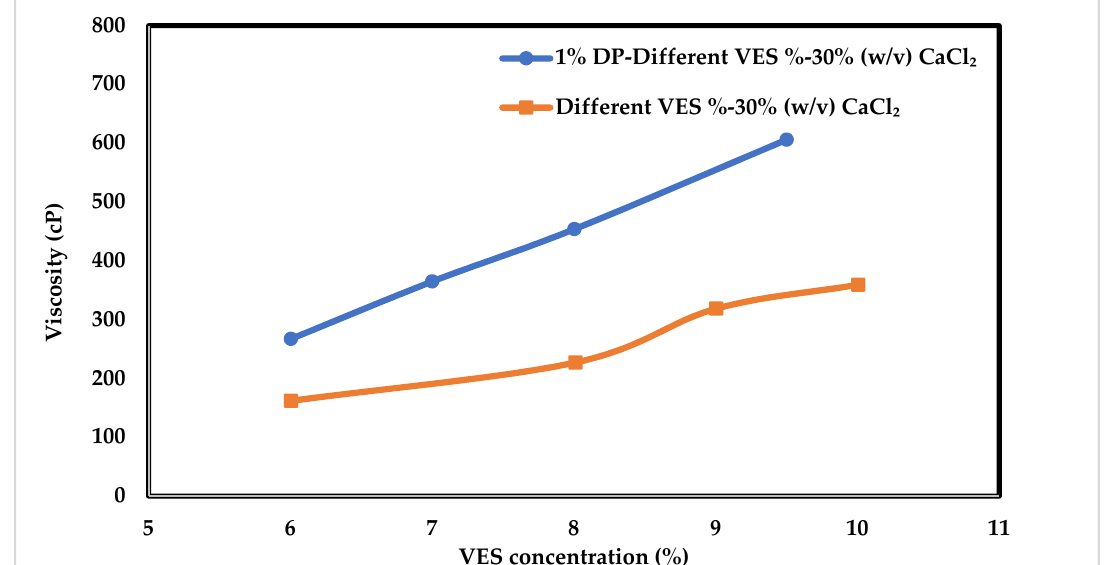
Figure 11. Viscosity variation with VES concentration at 300 ° F.